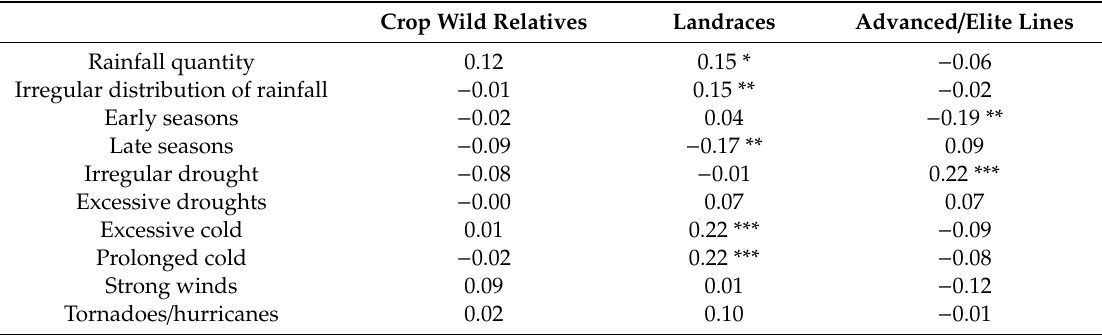
Table 4. Association between breeders’ perception of climate change and changes in their use of